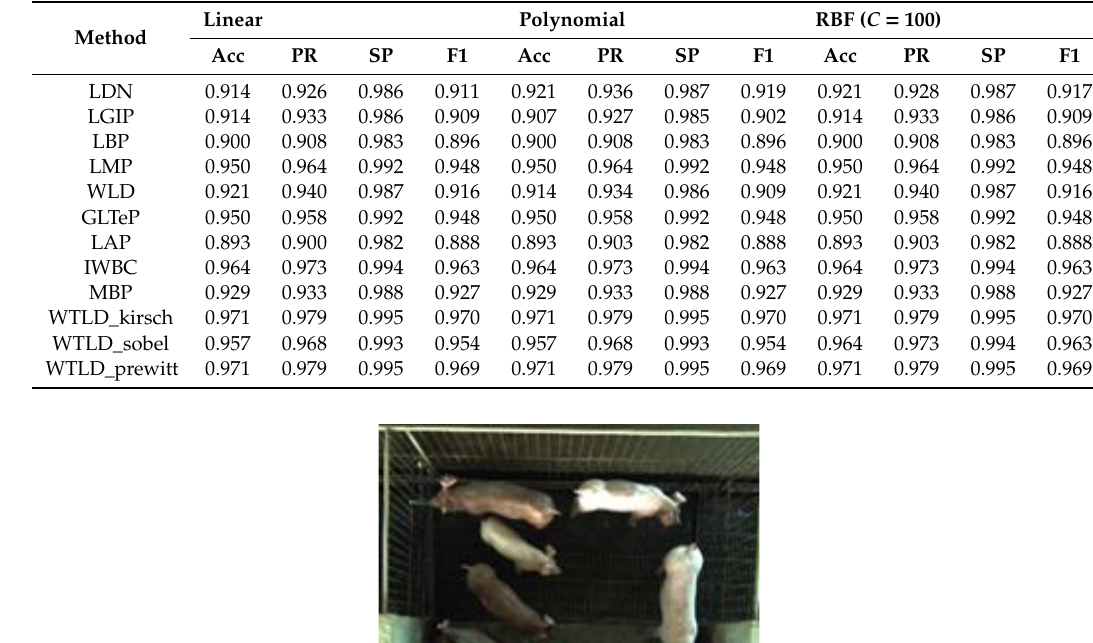
Table 6. Comparison of experimental results between WTLD and other local descriptors of dataset 1.